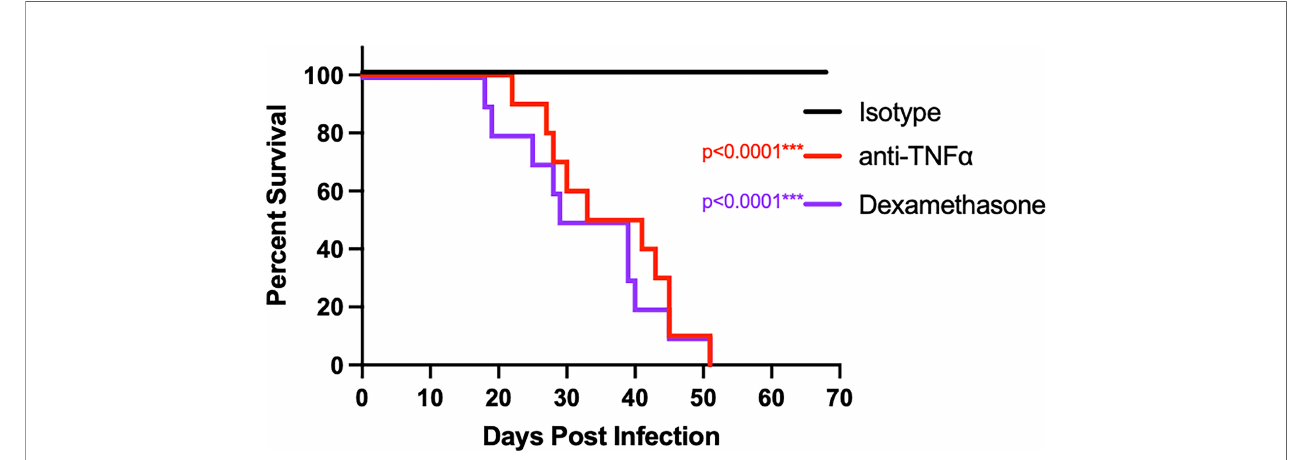
FIGURE 2 | Treatment of B6D2F1with anti-TNF a antibody results inprogressive Coccidioides disease. B6D2F1 mice were treated with 500 m g isotype control (black line) or anti-TNF a antibody (red line) starting onday -2 beforeinfection;dosingwas continued on an alternating q3/4d schedule. An additional cohort ofcontrols was treated with dexamethasone in their drinking water (purple line).Onday 0, mice were infected with ~50 arthroconidia of Cp1038 andfollowed for disease